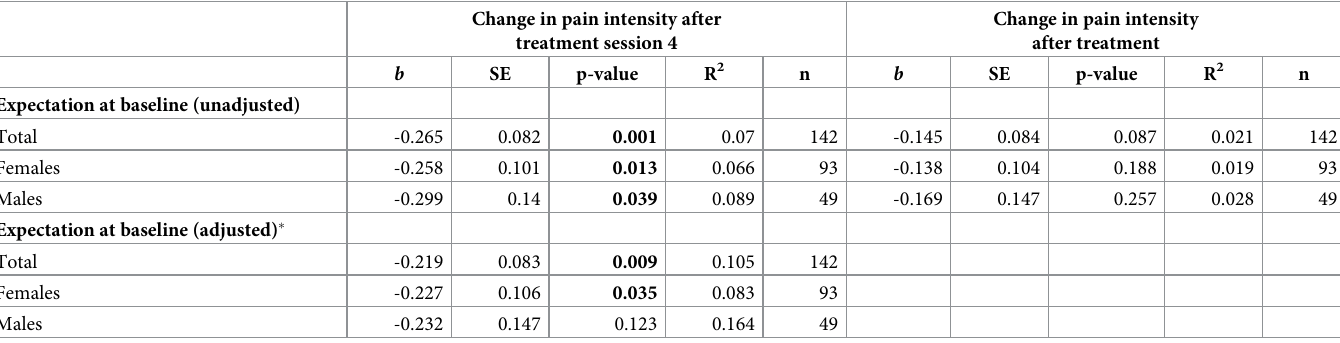
Table 2. Results of linear regression analysis for change in pain intensity as primary outcome and patient expectation as predictor presented as standardised betas.